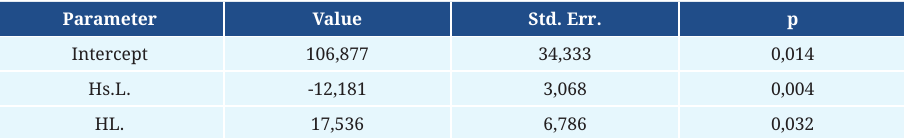
TABLE 1 | Parameters of general linear model (GLM) fitted to analyze the monthly marginal increment